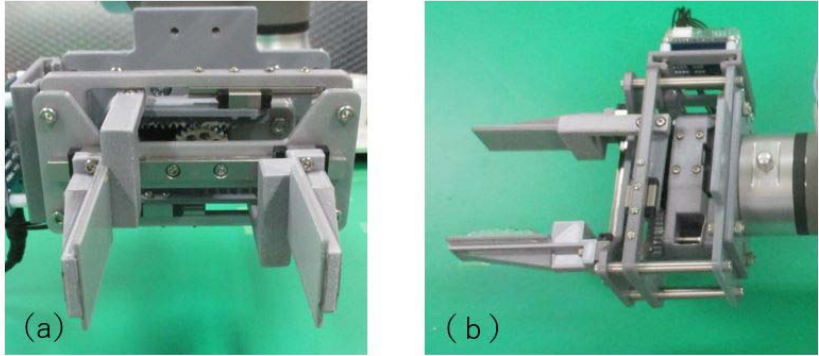
Figure 1. Photograph of manipulator: ( a ) front view, ( b ) top view.